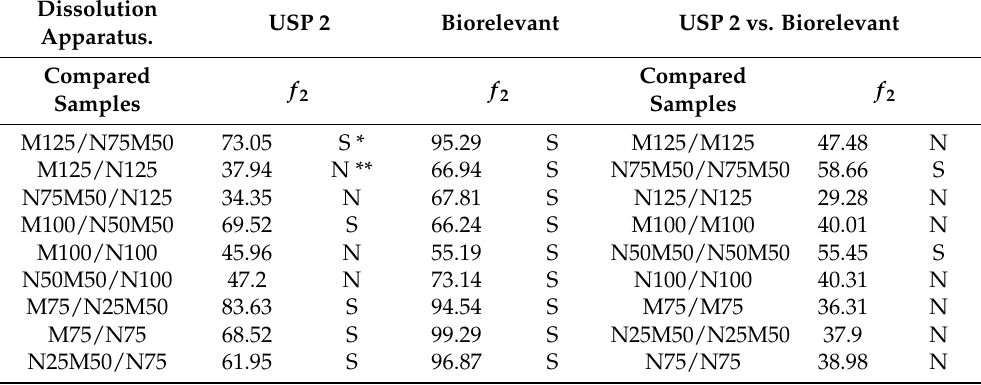
Table 4. Similarity factor